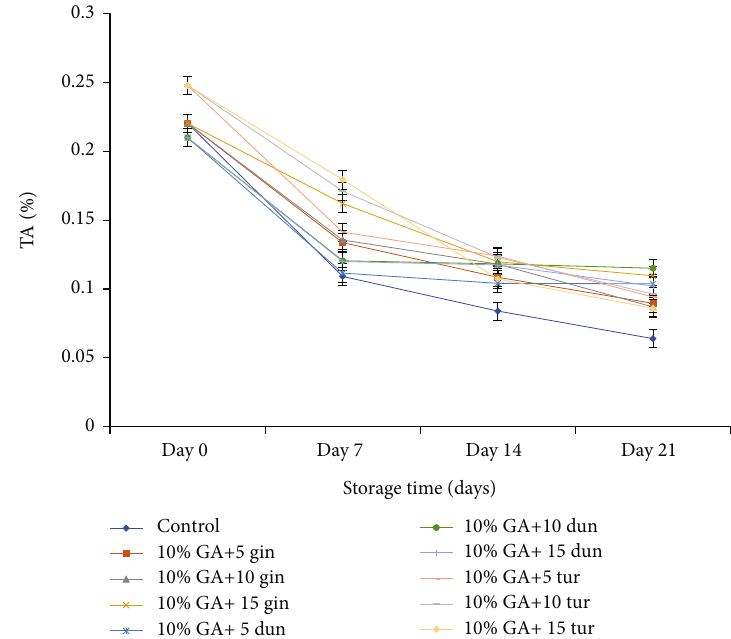
Figure 10: E ff ect of 10% GA incorporated with plant extracts at di ff erent concentrations on TA during cold storage for 21 days.